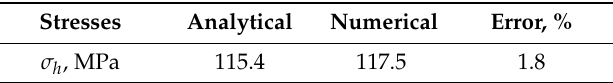
Table 8. The results of hoop stress testing.